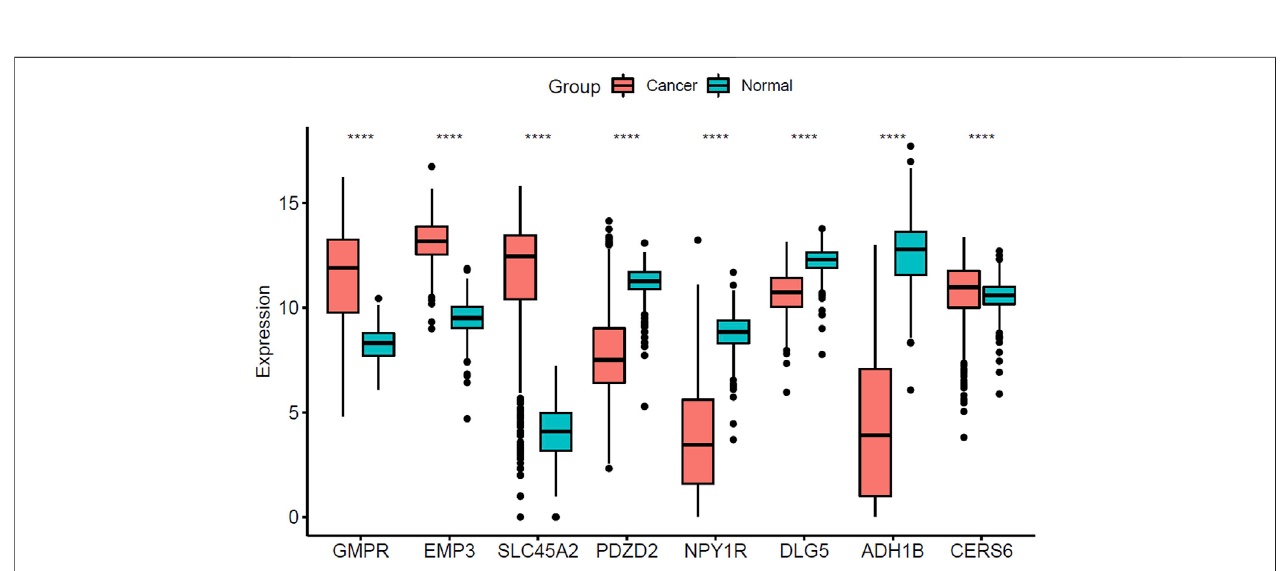
FIGURE 7 | Boxplot of the three screened up-regulated genes (GMPR, EMP3, SLC45A2) and fi ve down-regulated genes (PDZD2, NPY1R, DLG5, ADH1B, CERS6) in TCGA-GTEx dataset. (**** p < 0.0001).